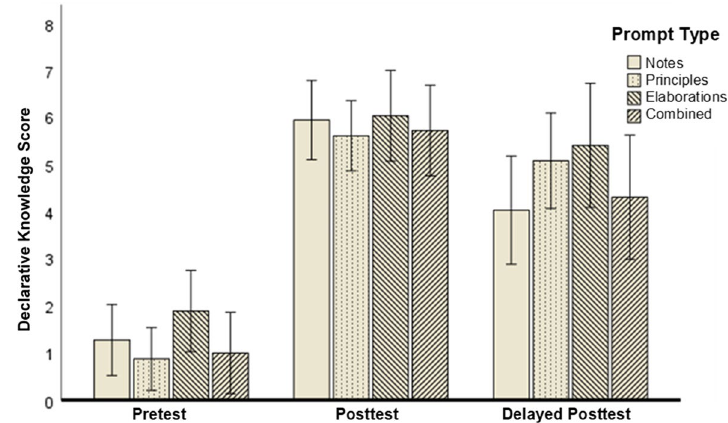
Fig. 3 Declarative knowledge with respect to prompt type and measurement time. Error bars: 95%